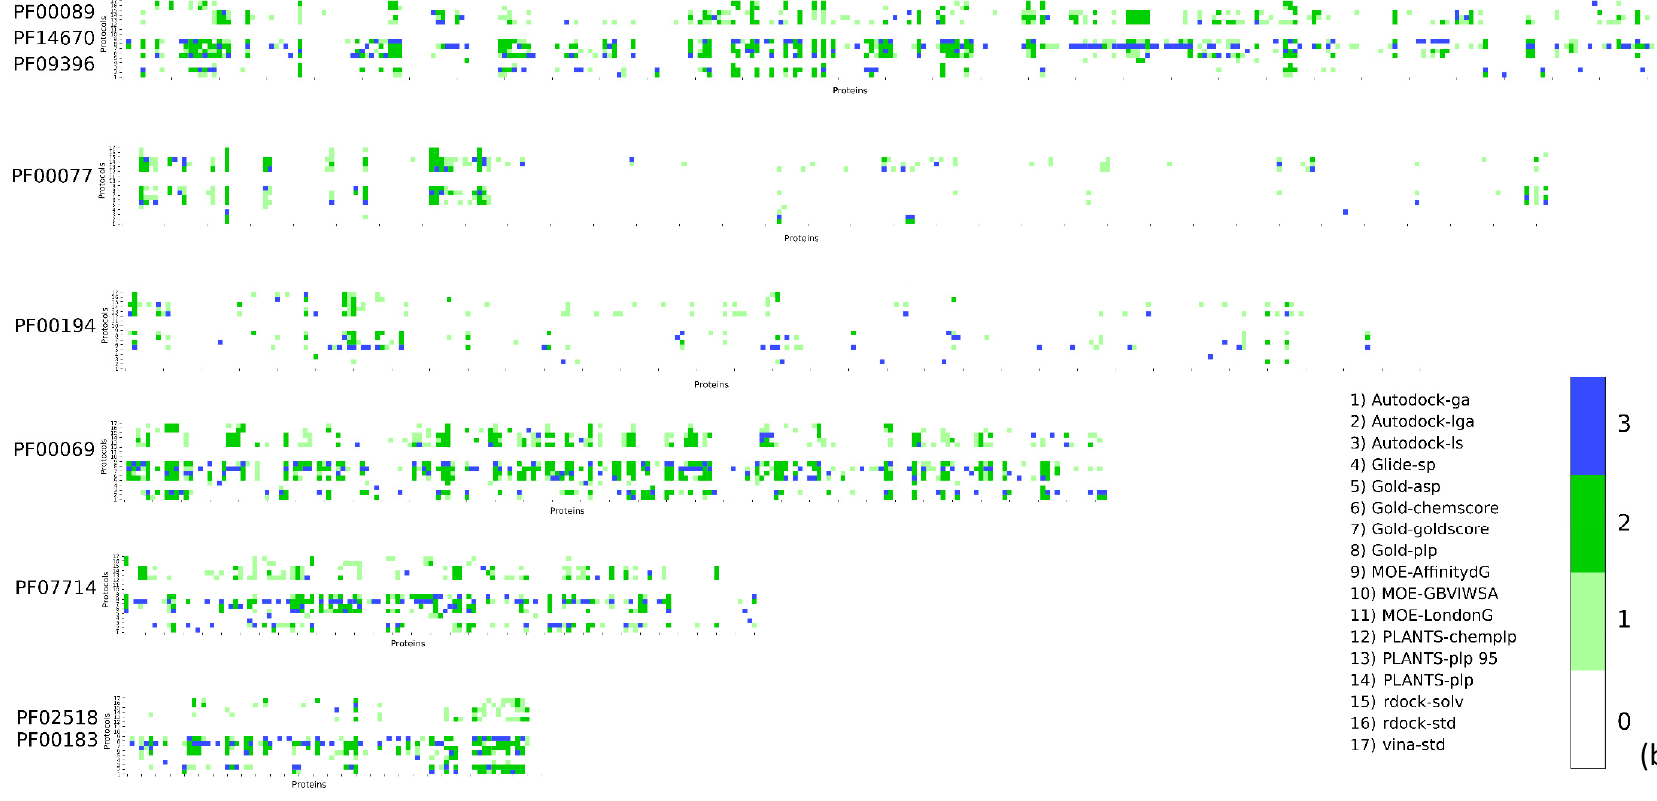
Figure 1. DockBench Results divided by Pfam protein families. The heatmaps are color-coded according to the P score . The ten families in panel ( a ) are: PF00439, Bromodomain; PF10613, Ligated ion channel L -glutamate and glycine-binding site; PF00102, Protein tyrosine phosphatases; PF000061 Lipocalin; PF00497, Bacterial extracellular solute-binding proteins family 3; PF00104, Hormone receptors; PF00026, Eukaryotic aspartyl protease Peptidase M_10; PF01048, Phosphorylase superfamily; PF00233, 3 ′ 5 ′ -cyclic nucleotide phosphodiesterases. The six families in panel ( b ) are: PF00089 Trypsin, PF14670 Coagulation Factor Xa inhibitory site, PF09396 Thrombin light chain, PF00077 Retroviral aspartyl proteases, PF00194 carbonic anhydrases, PF00069 protein kinase, PF07714 tyrosine kinase, PF02518 GHKL domain, and PF00183 HSP90.